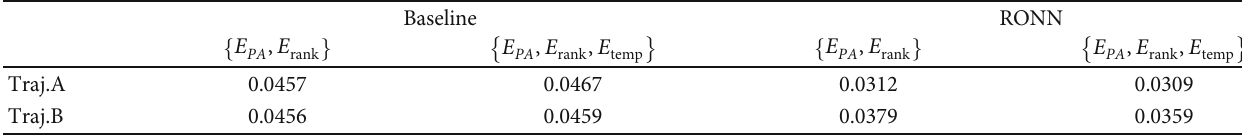
Table 2: e on di ff erent loss function 3 D